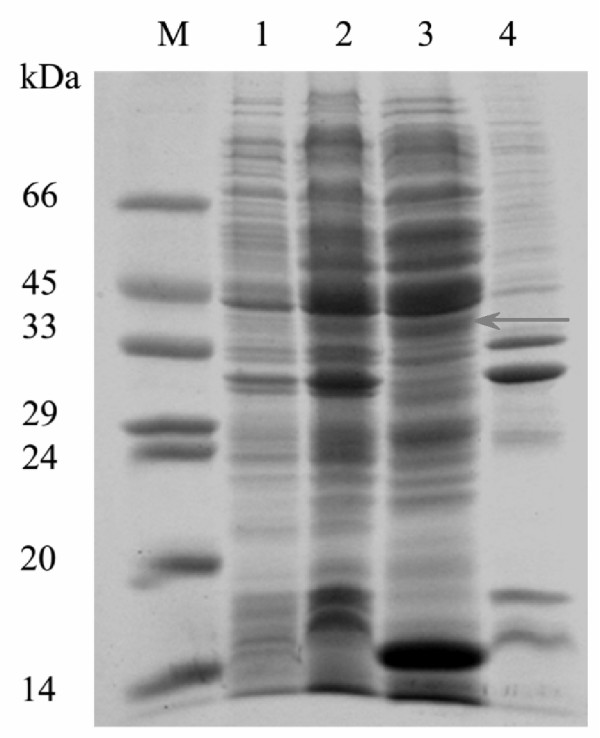
Expression of GGPP synthase in pBluescript II KS-vector analysed by SDS-PAGE. M = molecular mass standards are indicated in kDa; lane 1 = control (E. coli transformed with pBluescriptII KS-); lane 2 = total protein extract after 6 hours of IPTG induction; lane 3 = soluble cytoplasmic fraction of cells treated with IPTG; and lane 4 = insoluble fraction of cells treated with IPTG